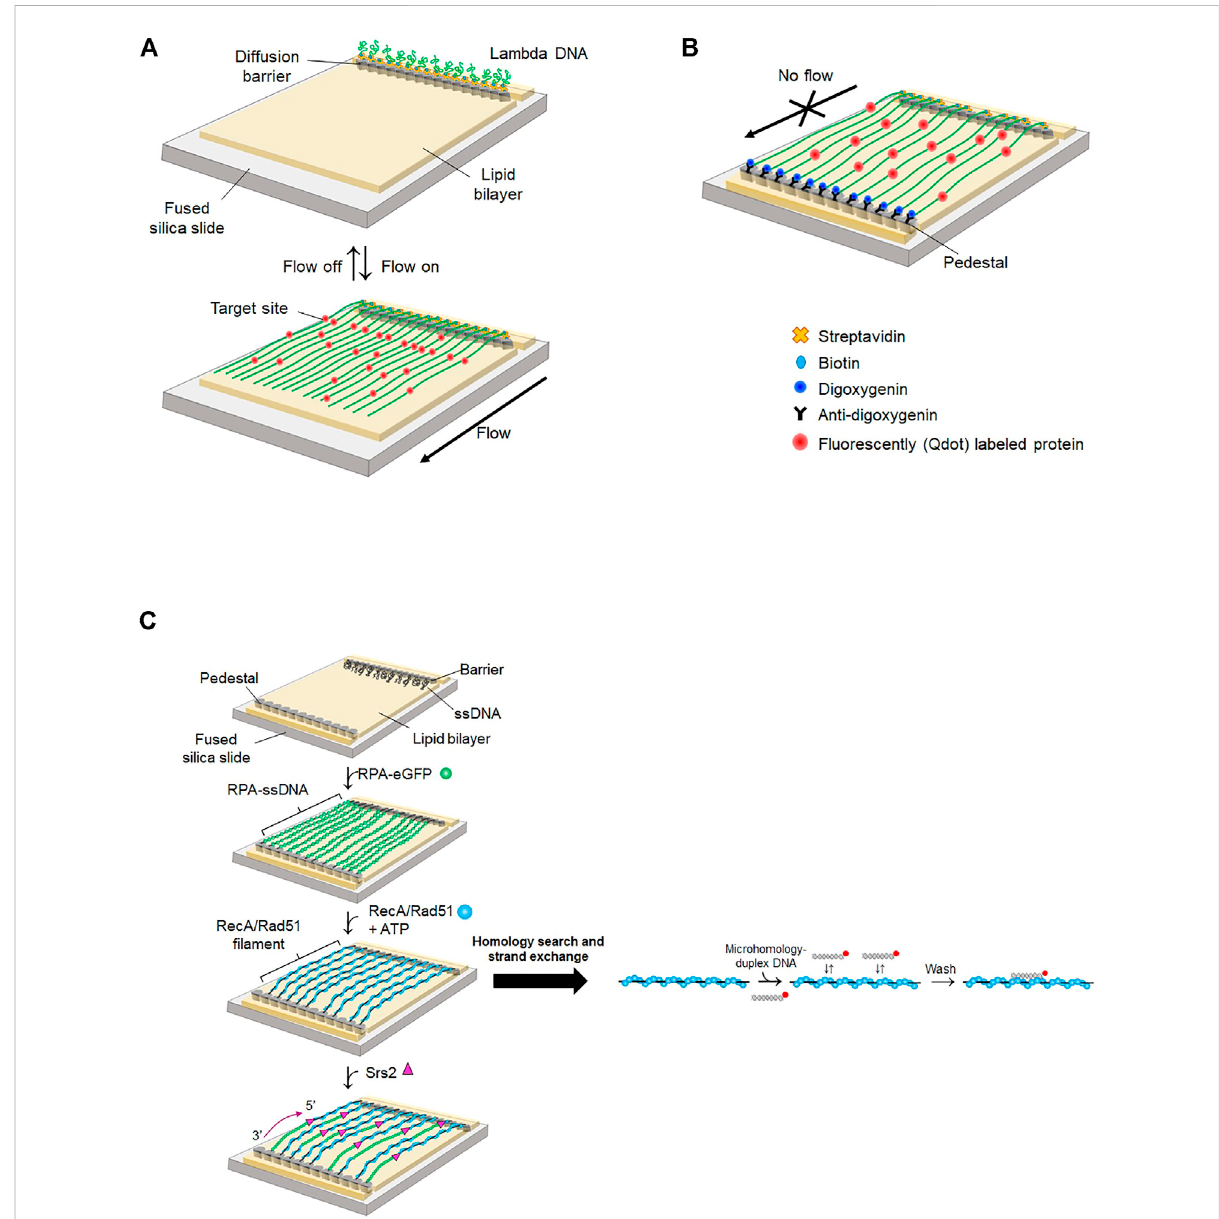
FIGURE 5 DNA curtain. (A) Single-tethered DNAcurtain(ST-DNAcurtain). Oneend of lambda DNA isanchored on alipid molecule via biotin-streptavidin linkageandtheotherendisfree.Whenbuffer fl owisswitchedoff,DNAis fl exiblycoiled,whereasDNAisstretchedandalignedatadiffusionbarrierin thepresenceofbuffer fl owthatexertsahydrodynamicshearingforce toDNA. ProteinsarelabeledwithQdot.BothDNAand proteins areimaged by TIRFM. (B) Double-tethered DNA curtain (DT-DNA curtain). The other end of lambda DNA is tagged with digoxigenin and tethered to a nanometric pedestal, on which anti-digoxigenin is adsorbed. DNA remains stretched in the absence of buffer fl ow. Proteins are labeled with Qdot. BothDNAandproteinsareimagedbyTIRFM. (C) Single-strandedDNAcurtain.LongssDNAgeneratedbyrollingcircleampli fi cationisanchoredona lipid bilayer through biotin-streptavidin interaction. ssDNA molecules are extended and fl uorescently imaged by RPA-eGFP. In the absence of free RPA-eGFP, recombinase such as RecA or Rad51 replaces RPA from ssDNA. Homology search and strand exchange are examined by dissociation of fl uorescently labeled microhomology-containing duplex DNA from the presynaptic complex. Srs2, an anti-recombinase, detaches Rad51 from ssDNA and promotes re-association of RPA-eGFP from the 3 ′ end of